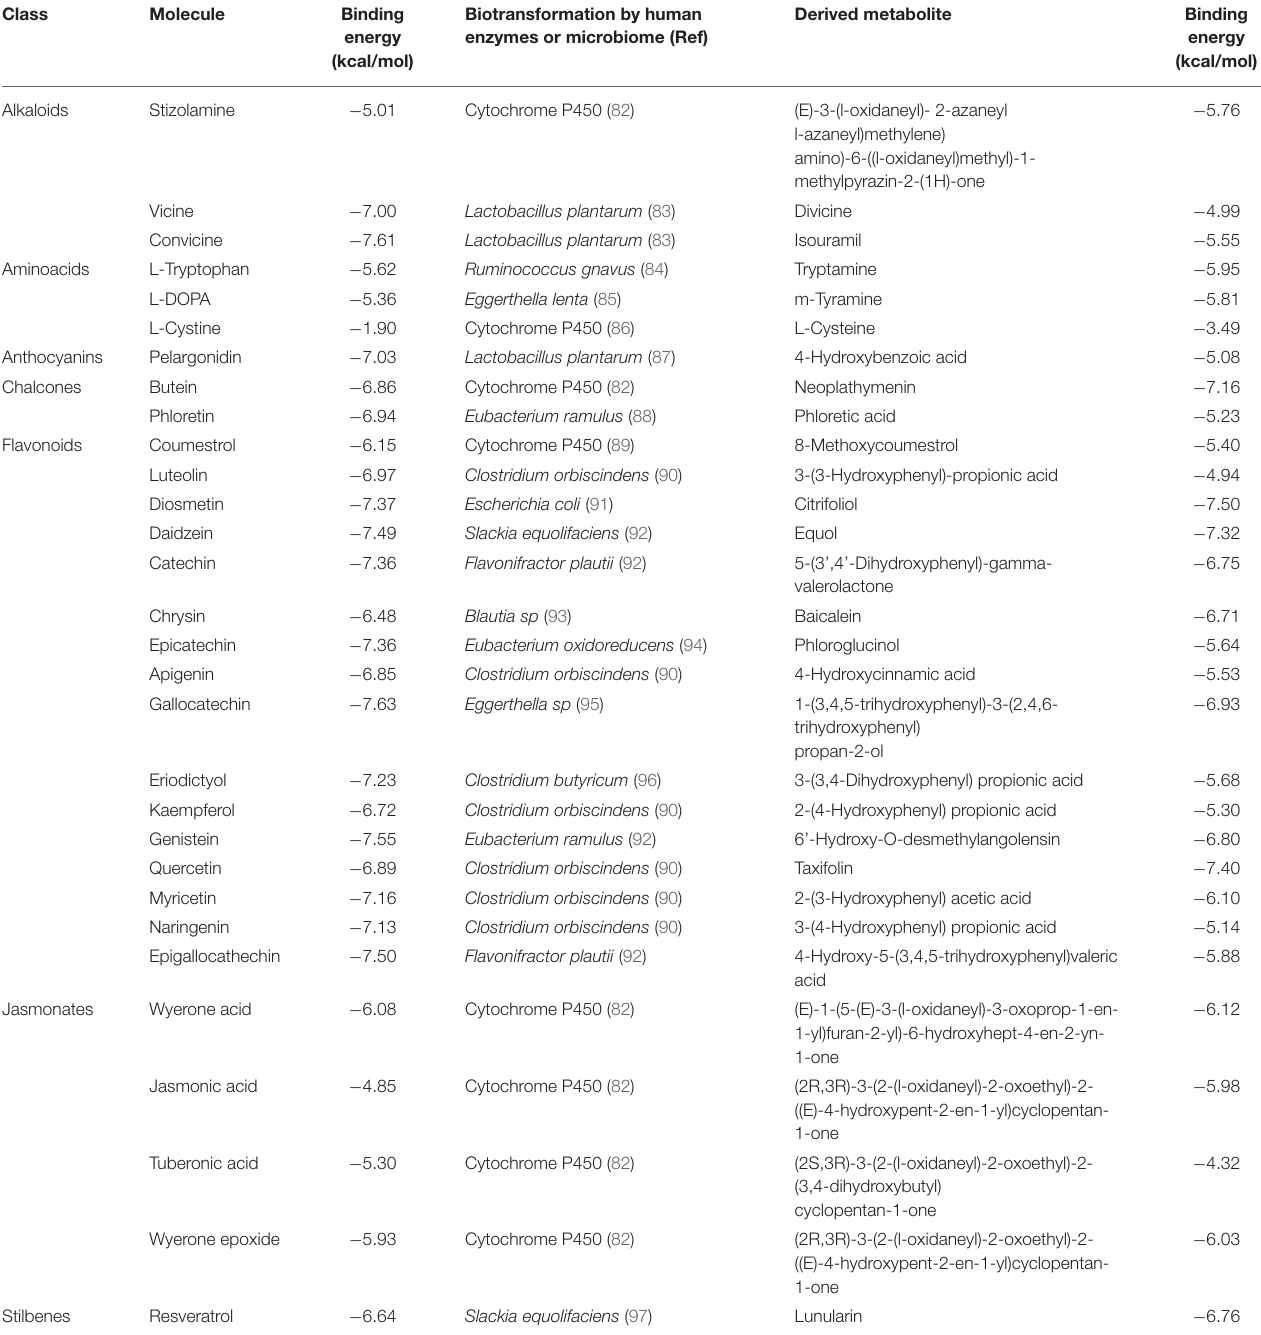
TABLE 1 | Results of the simulations to assess the binding energy of compounds that characterized the chemical profile of Vicia faba beans against the PAS-A domain of the AhR before and after their human or microbiome biotransformation. Class Molecule Binding Biotransformation by human Derived metabolite Binding energy enzymes or microbiome (Ref) (kcal/mol)